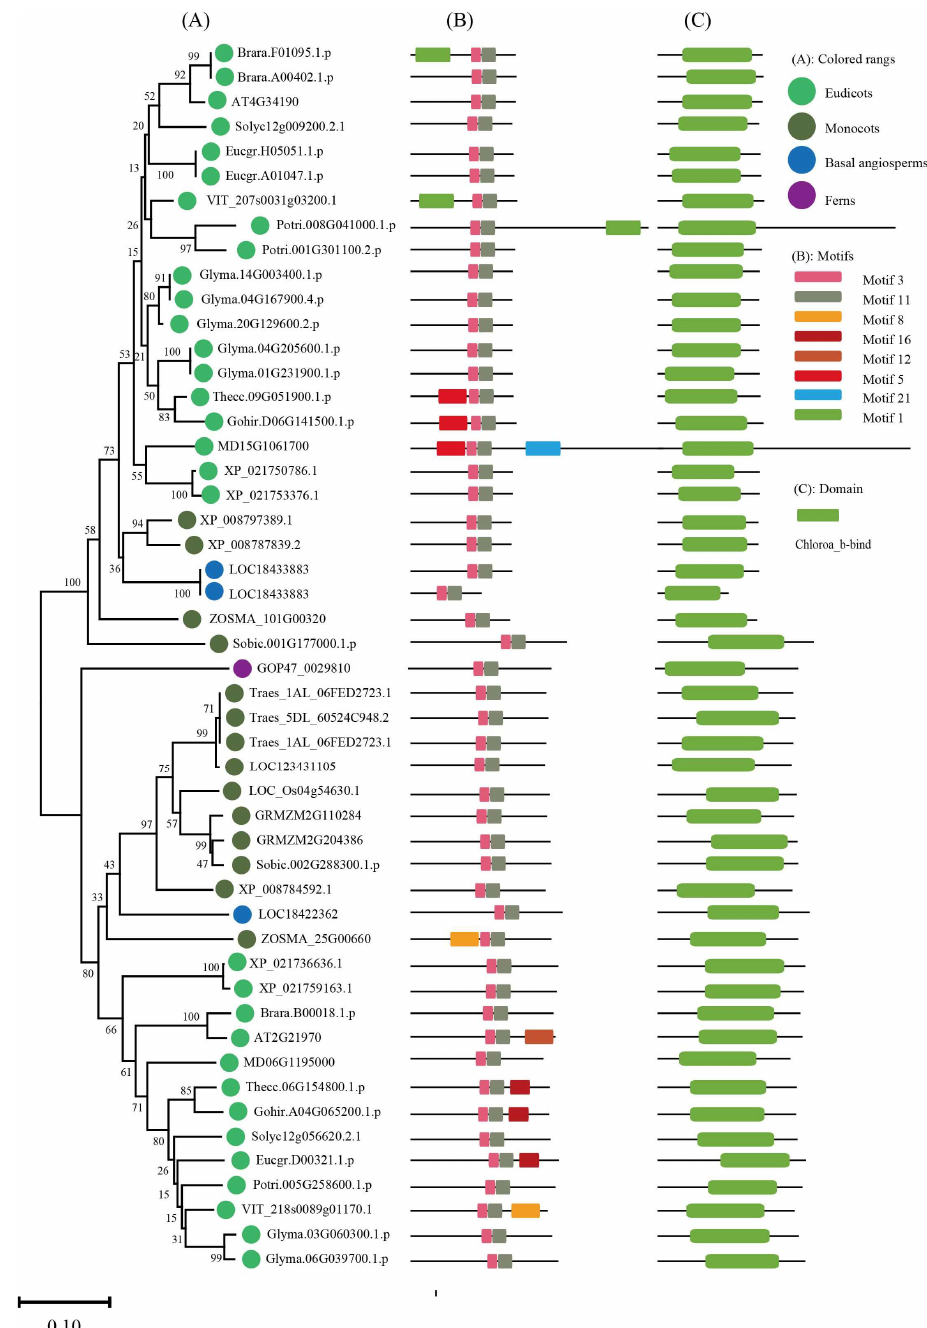
Figure 4. Phylogenetic evolutionary tree, protein motifs, and domains of the SEP subfamily members: ( A ) Unrooted phylogenetic tree of the SEP subfamily; ( B ) motifs of the SEP proteins. The different colors indicate eight motifs (left panel); ( C ) protein domains of the SEP genes.